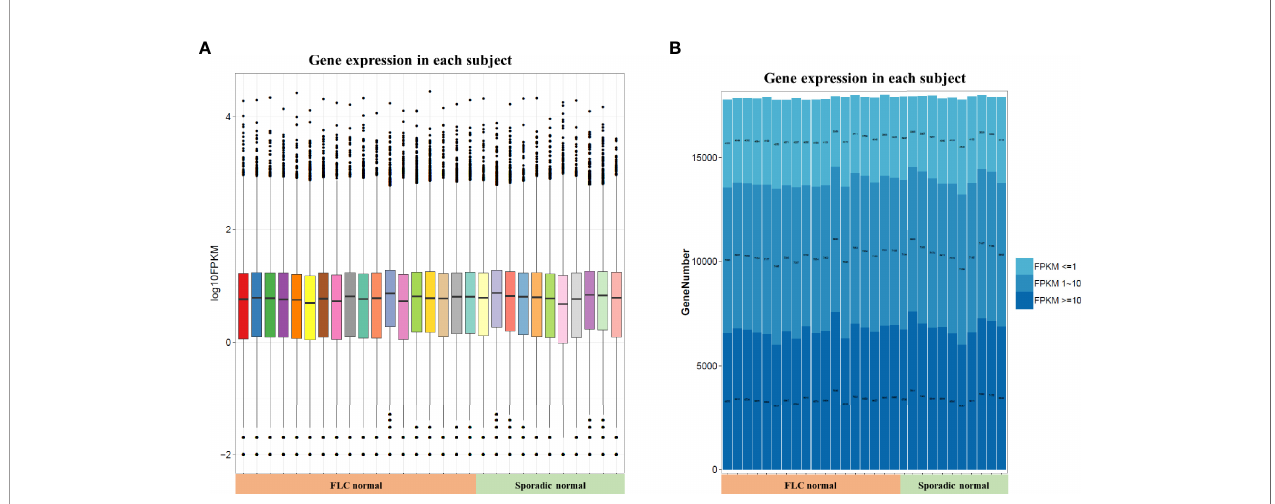
FIGURE 4 | Host normal lung tissue gene overall expression. (A) Box-plot of overall gene expression in each subject. X-axis represented each sample, in the related subgroup. Y-axis represented the log 10 FPKM value. Five lines from bottom to top is the minimum value, the fi rst quartile, mean, the third quartile, and the maximum value, and the extreme values were shown as black dots. (B) Gene expression distribution in each subject. Which showed the gene amount under three different FPKM ranges (FPKM <= 1 、 FPKM 1~10 、 FPKM >= 10)X-axis represented each sample, in the related subgroup. The Y-axis represented the gene amount; the dark color meant the high expression level which FPKM value >= 10, while the light color meant the low expression level which FPKM value <= 1. FPKM: Fragments Per Kilobase per Million, FPKM is a unit used in RNA-seq, which represents gene expression level; the bigger FPKM value, the higher gene expression